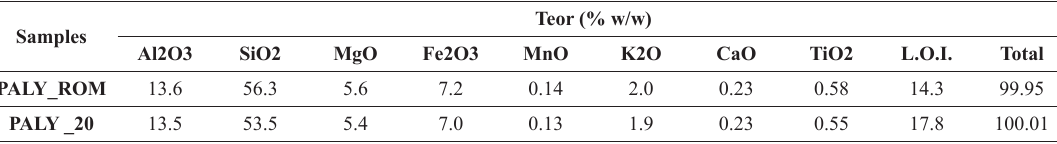
Table 2. Chemical composition of palygorskite samples before (PALY_ROM) and after PALY_20) ore dressing. Samples